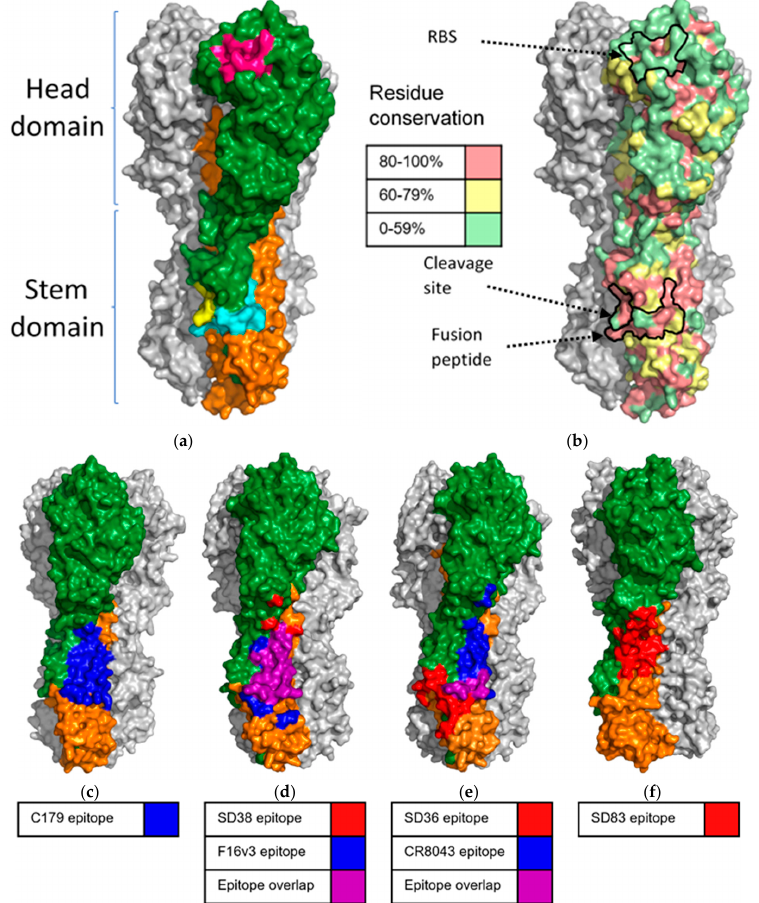
Figure 2. Structure of HA and epitope footprints of HA stem binding sdAbs and conventional antibodies with similar ranges of cross-reactivity. ( a ) Structure of hemagglutinin (A/California/04/2009, PDB code 3LZG) [84]. One unit of the trimer is highlighted, HA1 is shown in green and HA2 is shown in orange. The fusion peptide, which, upon pH mediated conformational change, straightens and inserts into the host membrane is highlighted in cyan. The residues immediately surrounding the HA0 cleavage site are highlighted in yellow. The receptor binding site is shown in pink. ( b ) The same hemagglutinin structure is used to display a heat map of influenza residue conservation across 6 influenza A subtypes known to infect humans (H1, H2, H3, H5, H7 and H9) [85]. Key residues in the RBS, fusion peptide and cleavage site are highly conserved as well as many residues in the stem region at the HA1/HA2 interface. ( c – f ) Hemagglutinin trimer structures are used to display binding sites of sdAbs (blue), conventional antibodies (red) and areas of epitope overlap (purple). ( c ) The original stem binding antibody C179 is displayed on A/California/04/2009. ( d ) SD38 and F16v3 epitopes displayed on A/Hong Kong/1/68 HA (PDB code 4FNK) [24]. ( e ) SD36 and CR8043 epitopes displayed on A/Hong Kong/1/68 HA. SD38 and pan influenza A conventional antibodies have a high degree of overlap in their epitope footprints while SD36 and Group 2 stem binding conventional antibodies have sharply contrasting epitope footprints. This may indicate a difference in binding preference between conventional antibodies and sdAbs. ( f ) SD83 epitope displayed on B/Brisbane/60/08 (PDB code 4FQM) [70]. The SD83 epitope has a greater degree of contact with HA2 compared to SD36 and SD38. The residues included in the epitope footprint were determined based on protein structures in complex (PDB codes 6FYU, 6FYT, 6FYW, 3ZTJ, 4NM8) [69,74,86] using the PBDePISA online tool